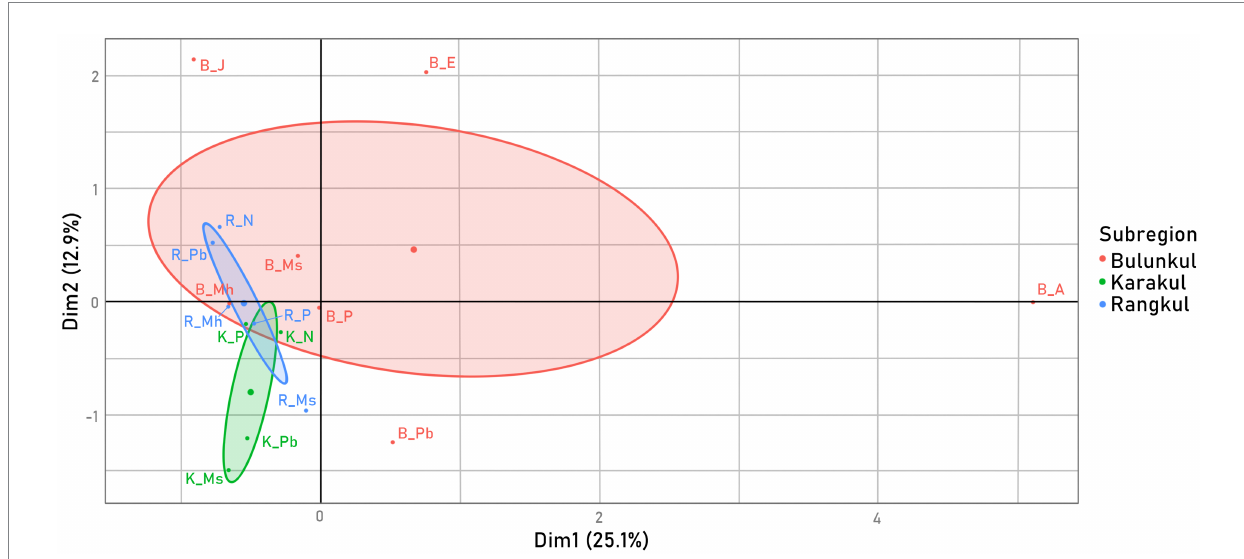
FIGURE 8 Variability of samples - MFA calculated from two factor groups of Cyanobacteria family reads from the representative groups: Oxyphotobacteria and other Cyanobacteria, colored by a supplementary factor group: subregion, which was not included in the samples’ placement